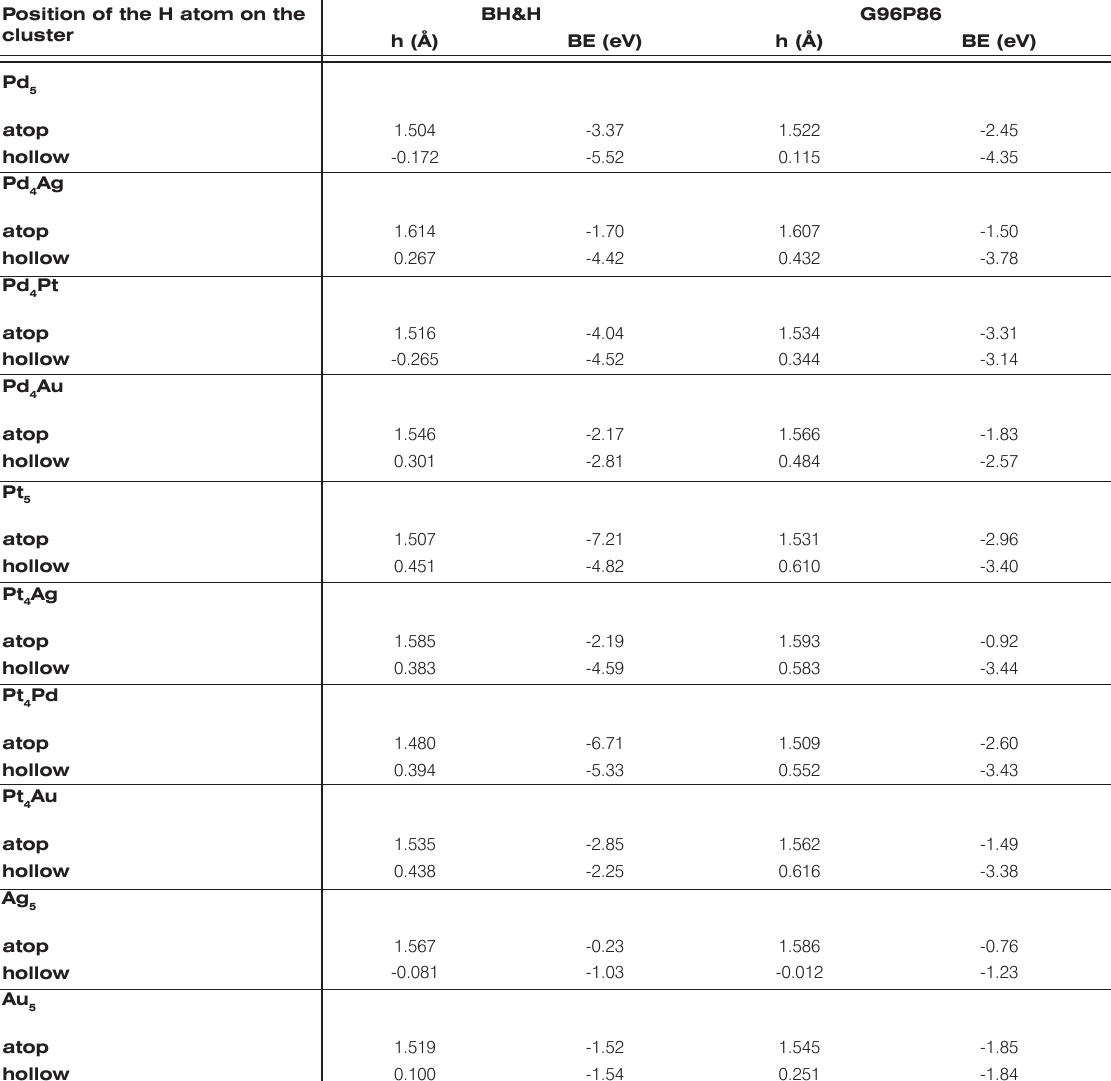
Table 4. Distances, h, of the H atom from the (100) surface of the mono- and bimetallic clusters and binding energies, BE, of the H on this surface in two characteristic adsorption positions Position of the H atom on the